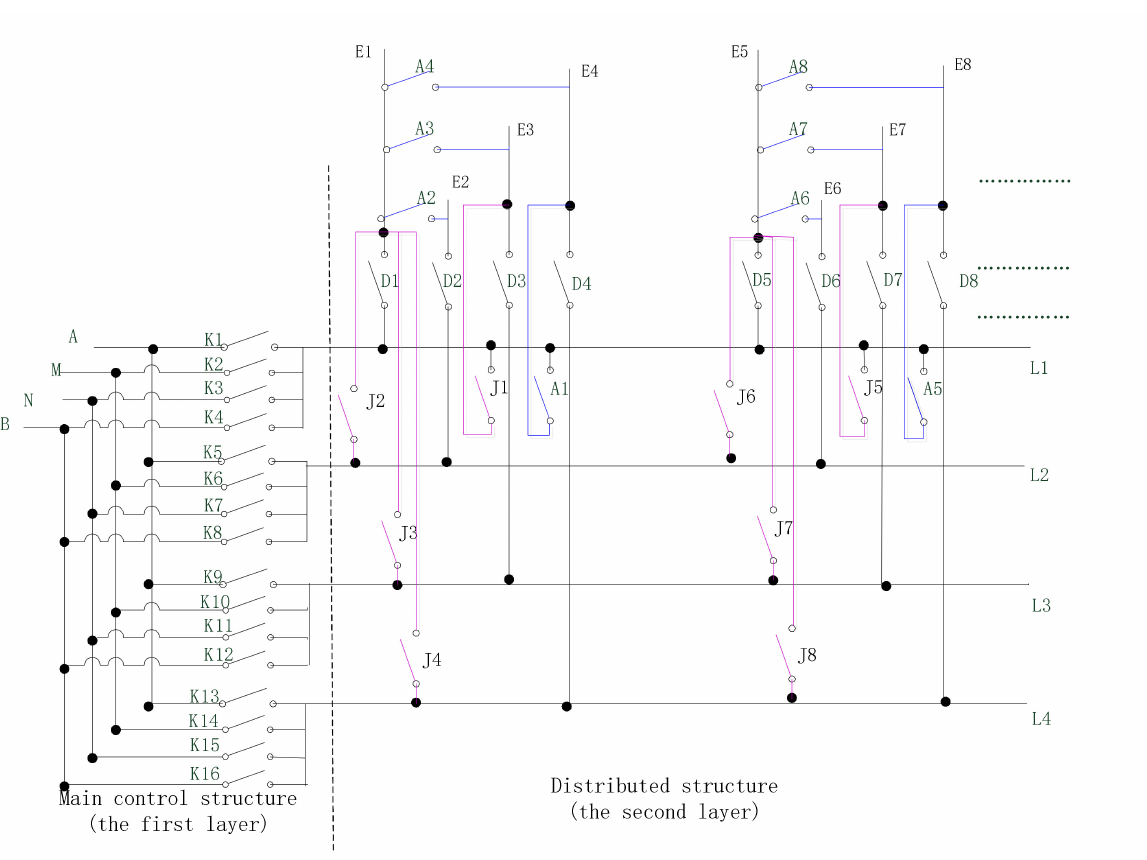
Figure 7. Topology structure of ESD for implementing all layer